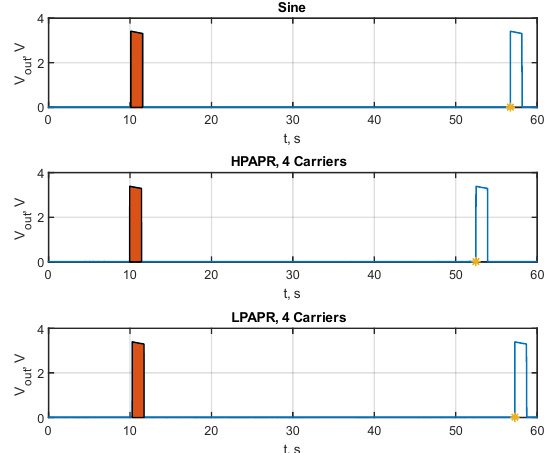
Fig. 7. DC-DC converter output voltage waveform with 10 kΩ load resistance with 4-subcarier multitone signals and sine